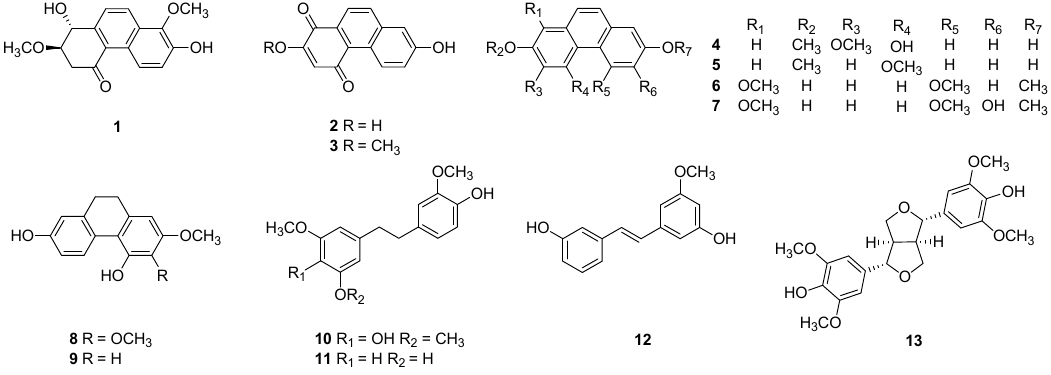
Figure 1. Chemical structures of compounds isolated from the ethyl acetate-soluble fraction of Dendrobii Herba.